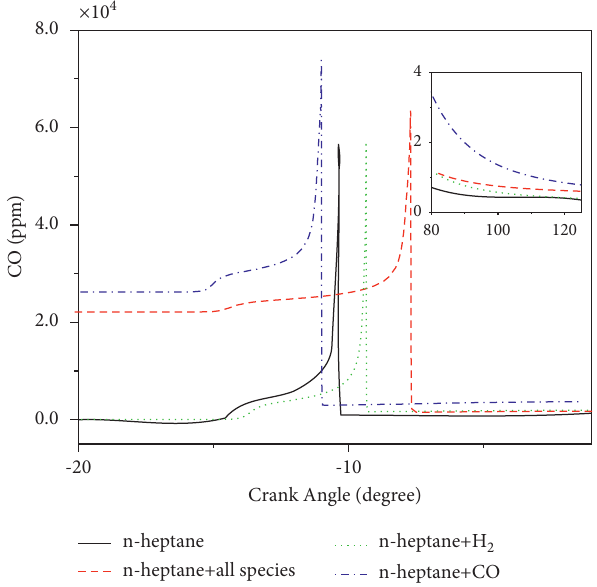
Figure 15: Effects of different reforming species on CO emission from the normal